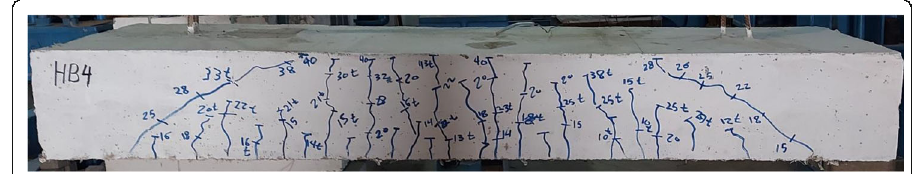
Fig. 10 Crack patterns at failure for shallow wide tested beam (HB4)